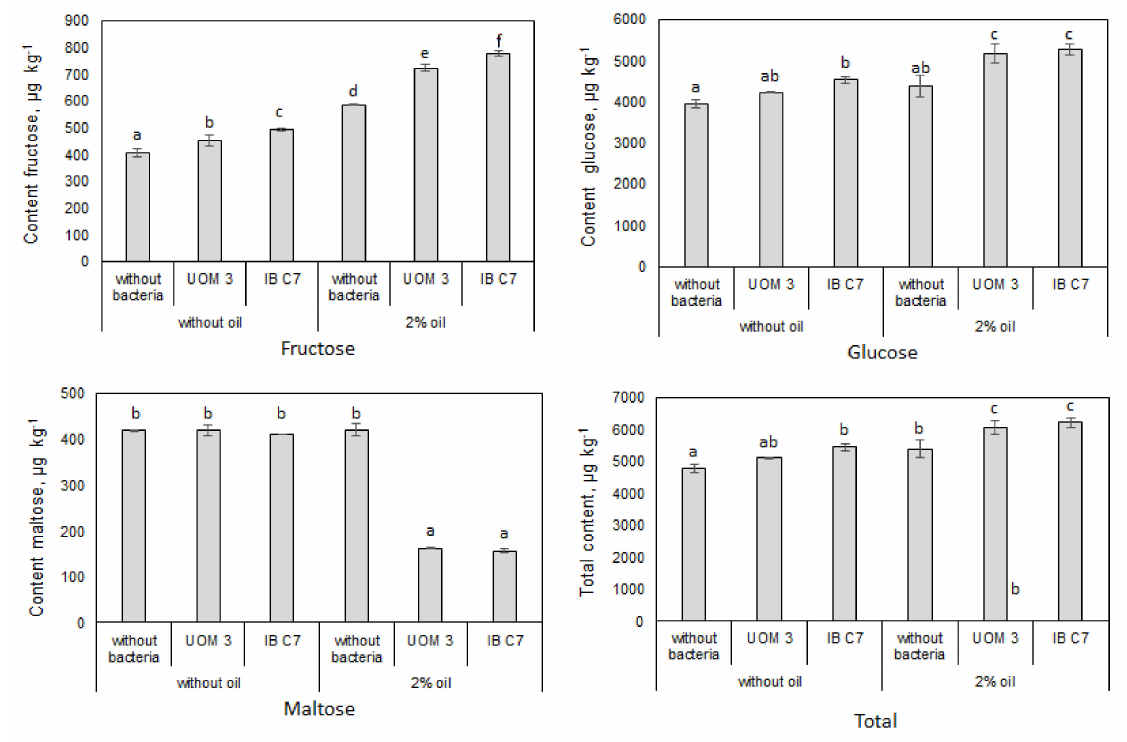
Figure 2. Content of sugars in pots planted with barley, µ g kg − 1 of sand. UOM 3 and IB C7—treatments with introduction of Enterobacter sp. UOM 3 and P. hunanensis IB C7, respectively. Statistically different means for each sugar (n = 9) are marked with different letters ( p ≤